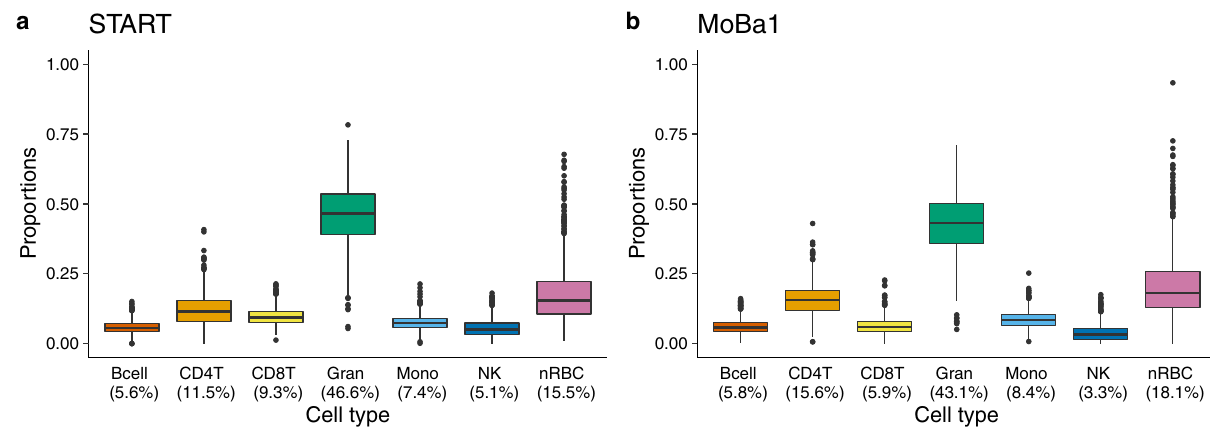
Fig. 1 Estimated proportions of seven main cell types in cord blood. a Estimated proportions of cell types in the START dataset ( n = 953, EPIC-based). b Estimated proportions of cell types in the MoBa1 dataset ( n = 1062, 450k-based). The upper and lower box limits correspond to the interquartile range (25 to 75% of the values for each cell type) and the horizontal line in the box represents the median value. The whiskers outstretch 1.5 times the box height from the top and bottom of the box. The dots outside the whiskers represent outliers beyond the interquartile range. The percentage below each cell type denotes the median proportion of that cell type. Bcell B-cell, CD4T CD4 + T-cell, CD8T CD8 + T-cell, Gran granulocyte, Mono monocyte, NK natural killer cell, nRBC nucleated red blood ( p = 0.033, Table 1). There were also more boys in MoBa1 than in START ( p = 0.007, Table 1).